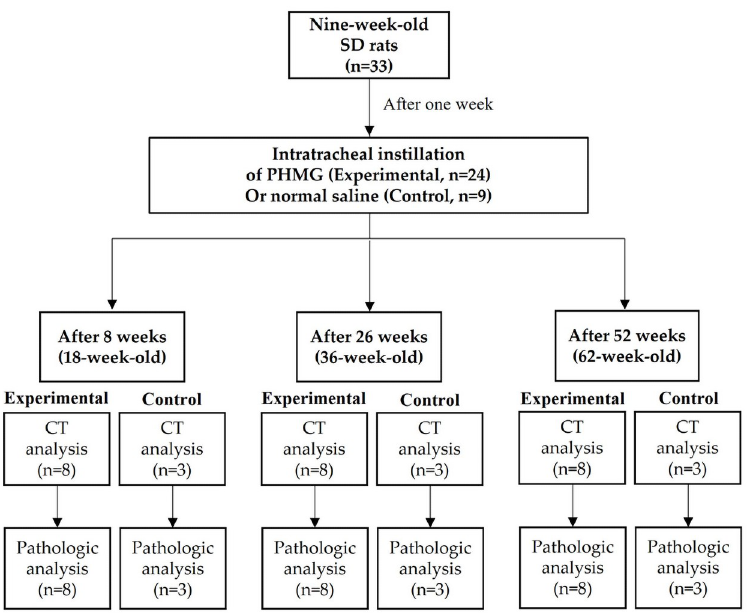
Fig 1. The experimental design. Conventional chest CT examination was conducted in all rats under anesthesia at 8, 26, or 52 weeks after instillation. Subsequently, the animals were sacrificed and both lungs were collected for histopathologic